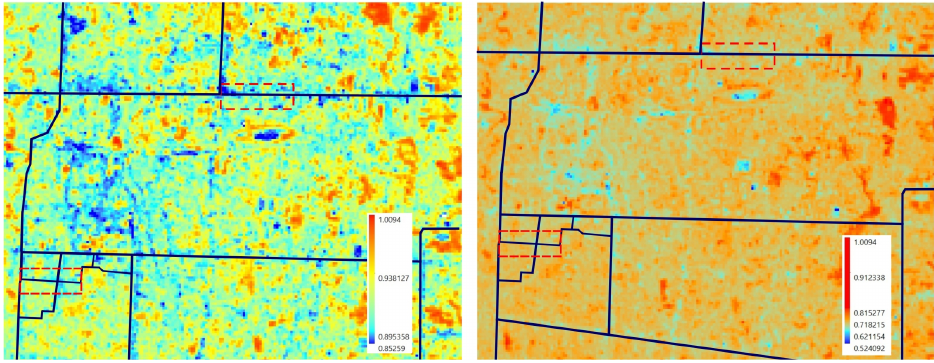
Fig. 7. Thermal emissivity maps retrieved from Landsat-8 OLI TIRS on May 5 at 02:47:15 (left) and August 25 at 21:50:13 (right).